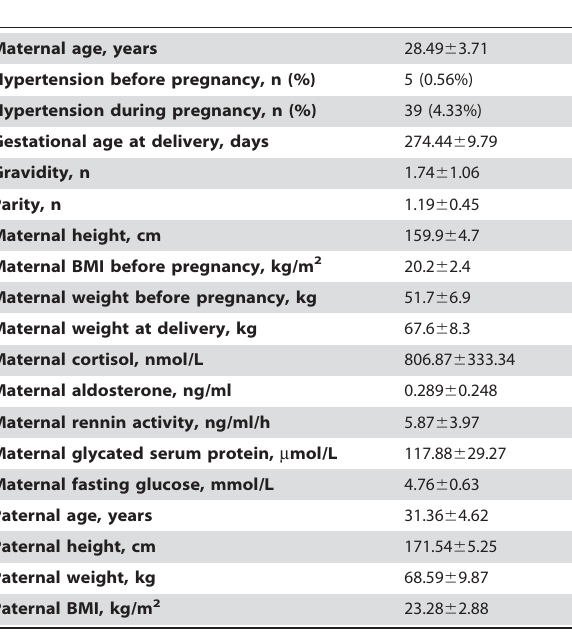
Table 1. Detailed descriptive data of the newborn’s mothers and fathers